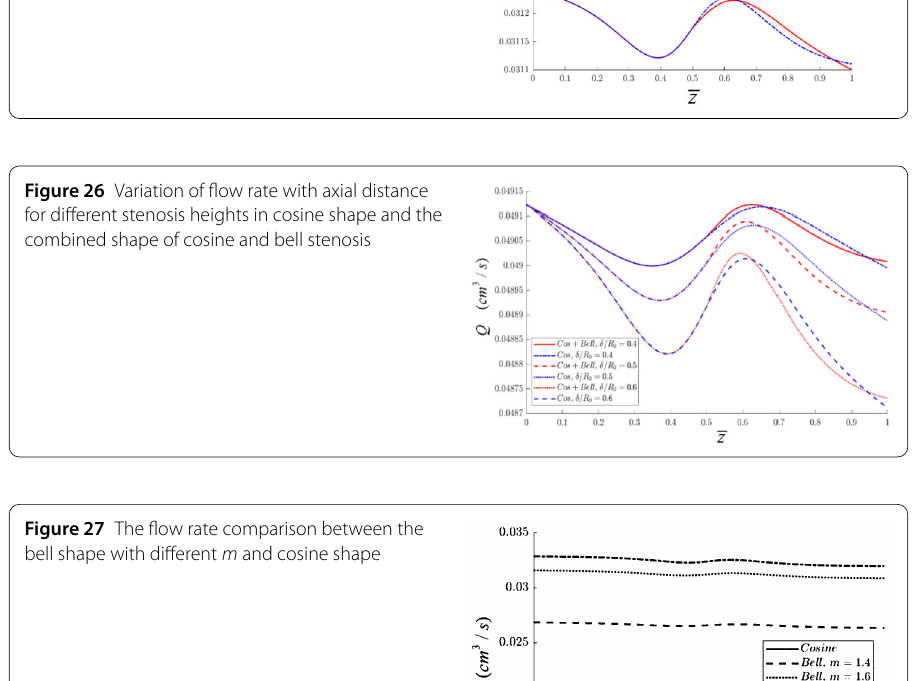
Figure 27 The flow rate comparison between the bell shape with different m and cosine shape